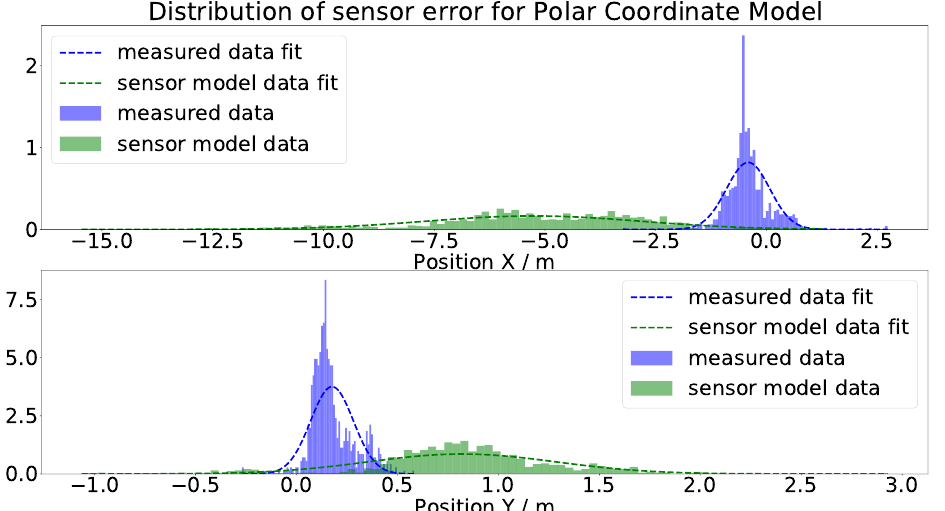
Figure 20. Results of the polar coordinate model by using the test data as the input.